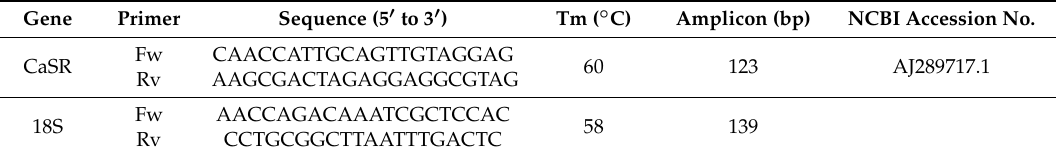
Table 1. Primes used for q-PCR expression analysis. (Fw-forward;